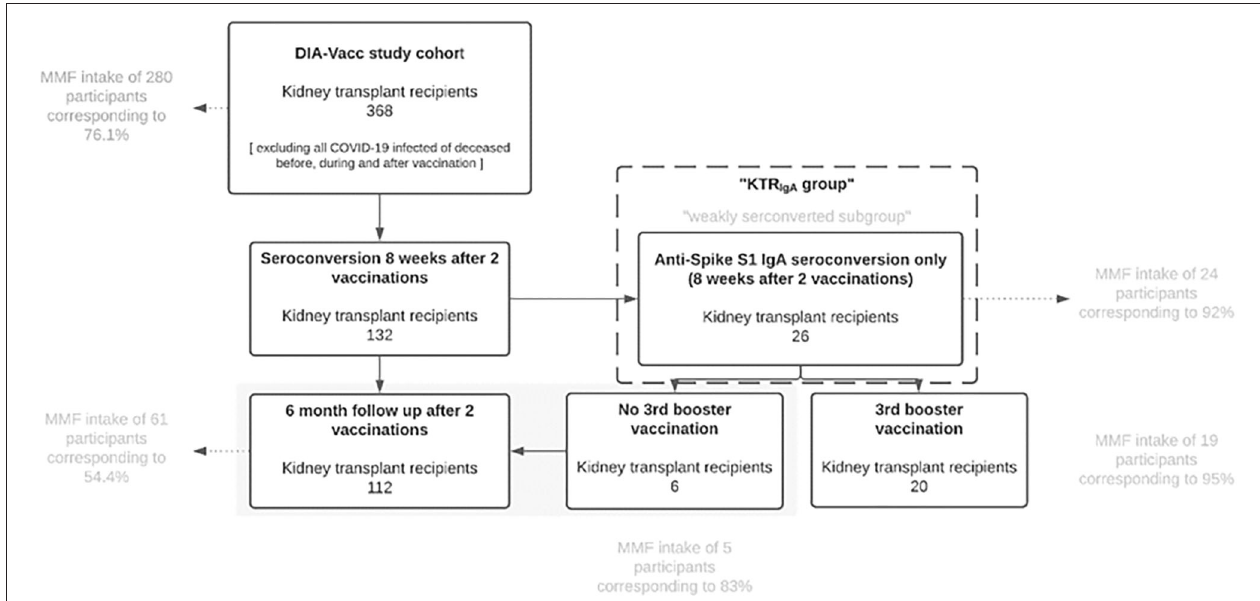
FIGURE 1 | KTR IgA group. KTR, Kidney Transplant Recipients; MMF, mycophenolate mofetil or mycophenolic